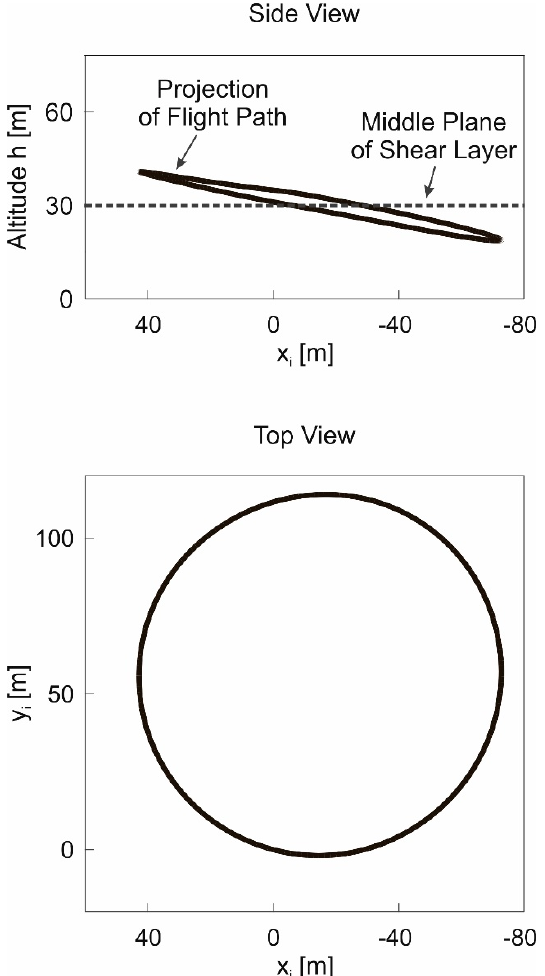
Figure 7. Side and top views of dynamic soaring loop optimized for maximum speed, V inert , max = 271.8